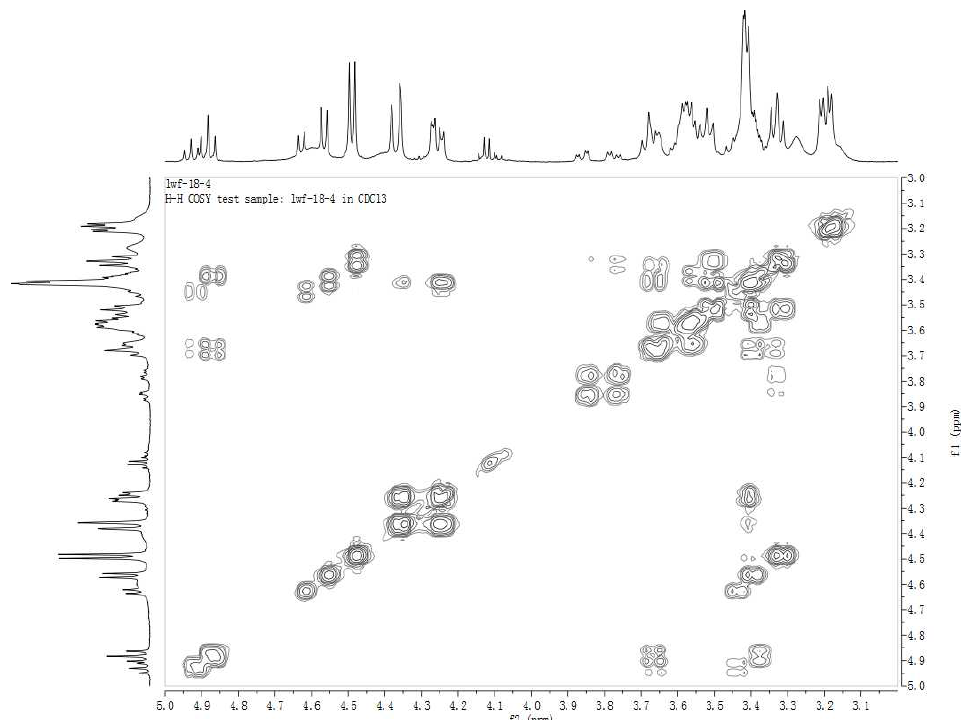
Figure 5. 1 H- 1 H COSY spectrum of 2C